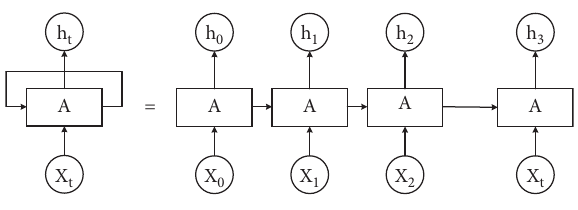
Figure 3: Te structure of